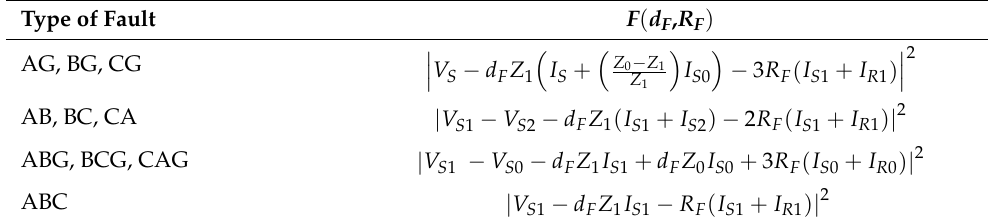
Table 6. Objective functions.